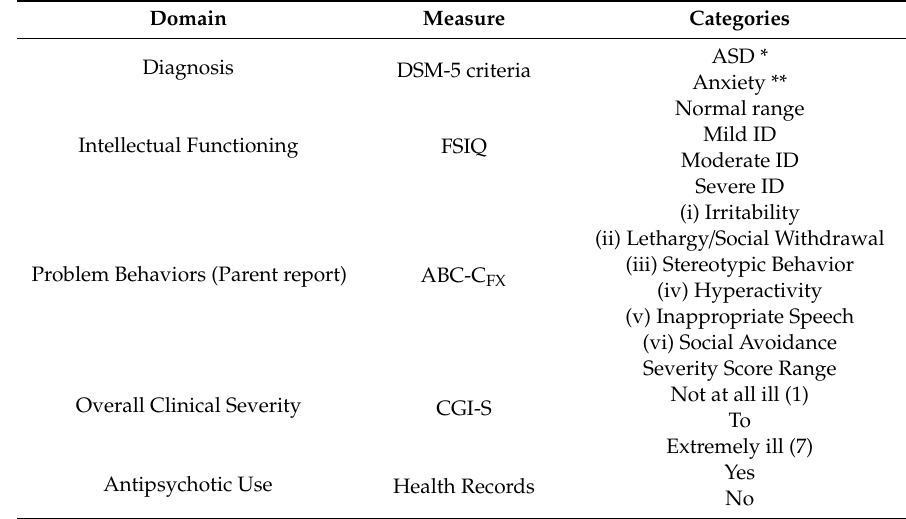
Table 3. Neurobehavioral assessments of the FM–FMRP